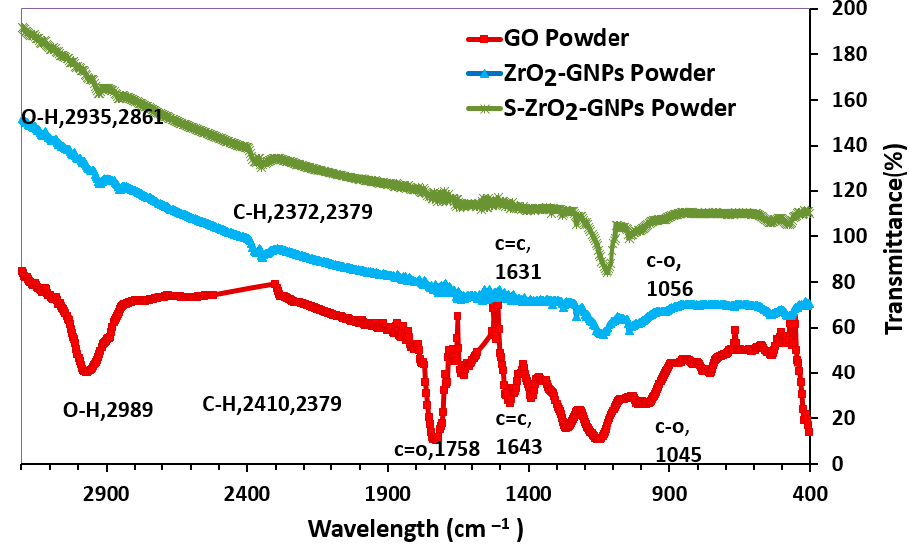
Figure 4. FTIR spectra of GO, ZrO 2 -GNPs, and S-ZrO 2 -GNPs.